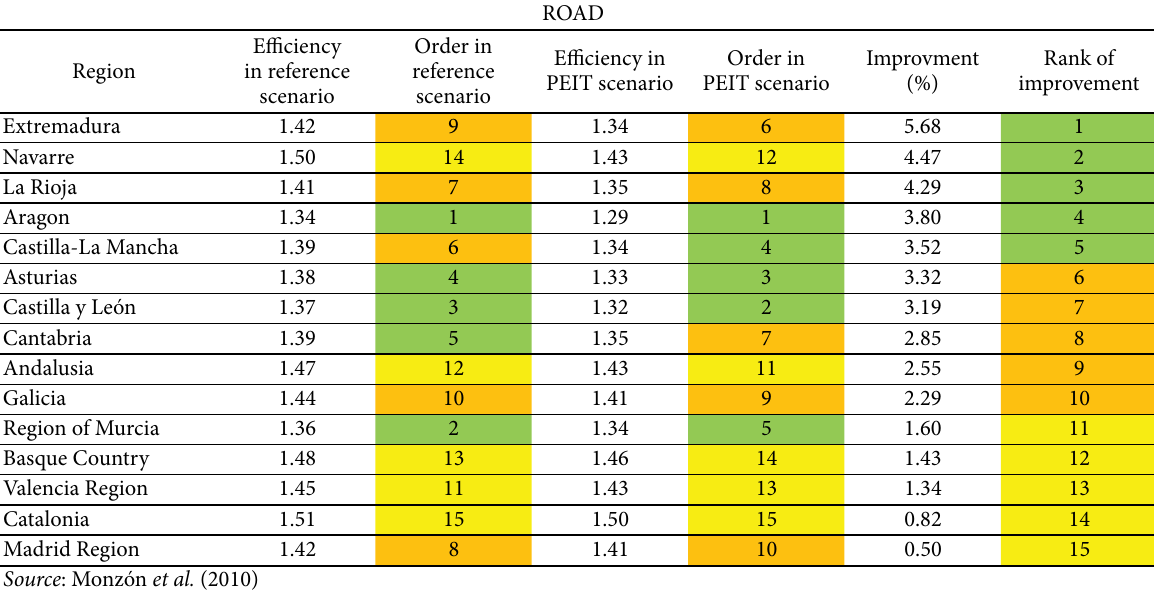
Table 4. Values and variation of accessibility by road in different autonomous regions ROAD